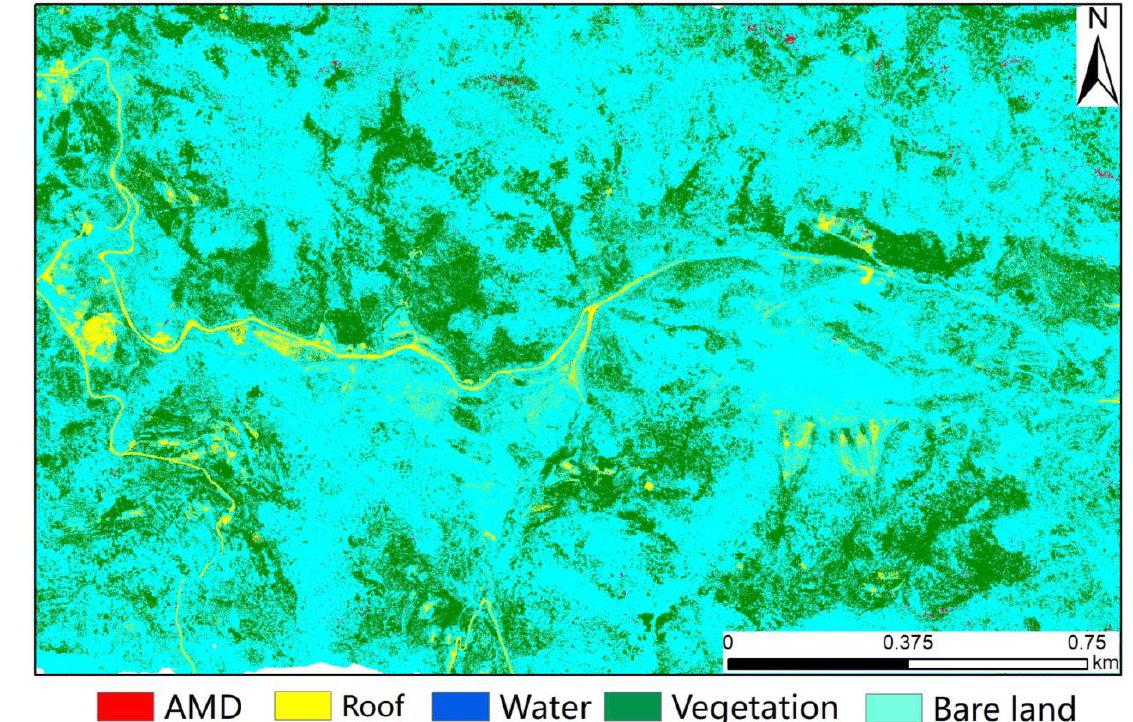
Figure 7. The classification map of SVM method.